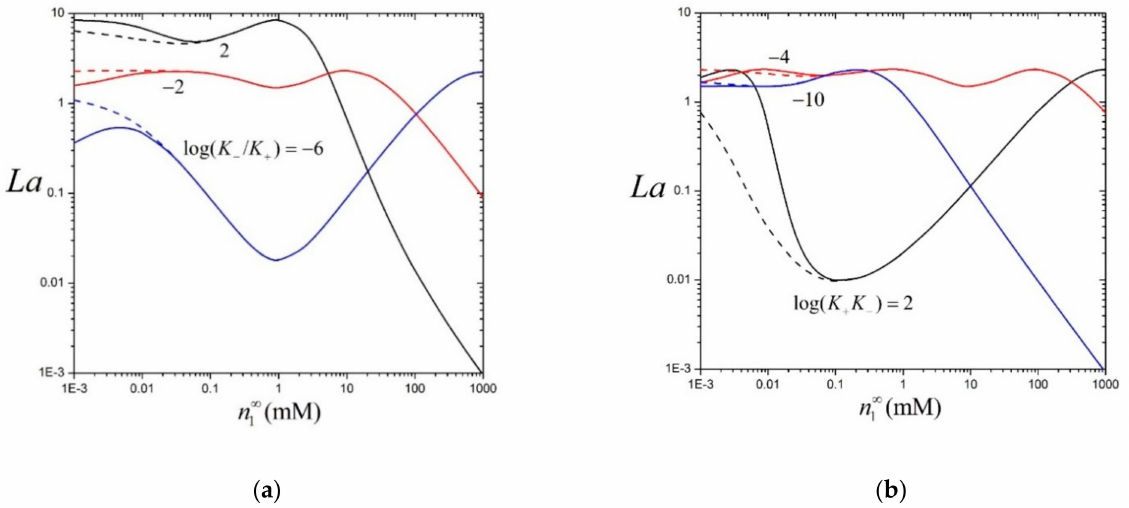
Figure 4. The dimensionless charge regulation parameter La versus the bulk concentration n ∞ solution in a fibrous medium with a = 100 nm and N = 1 × 10 16 site/m 2 : ( a ) K + K − = 10 − 6 M 2 ; ( b ) K − / K + = 10 − 2 . The solid and dashed curves represent the cases ϕ = 0.3 and ϕ = 0, respectively.